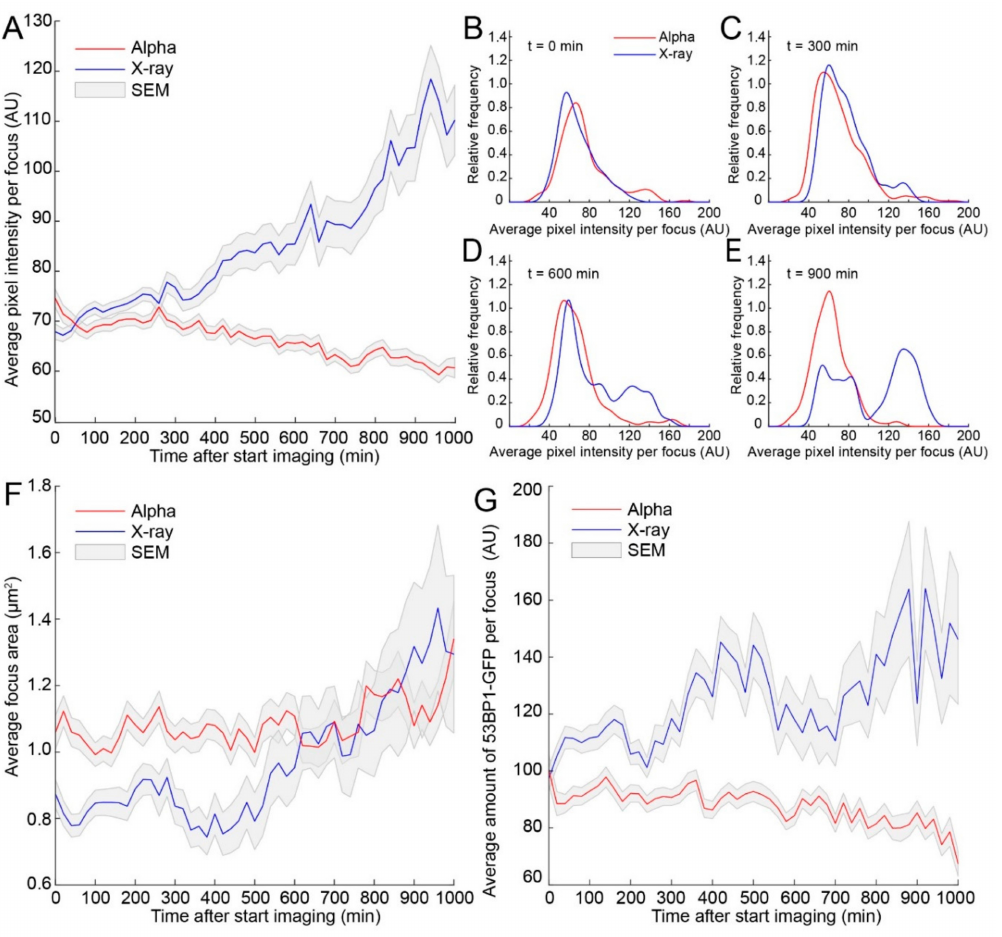
Figure 3. 53BP1-GFP protein accumulation and focus size increase after X-ray irradiation. ( A ) Average 53BP1-GFP intensity per focus (average pixel intensity) over time after treatment using α -particle (red) or X-ray (blue) irradiation (2 Gy). ( B – E ) Overview of focus population distribution at 0, 300, 600, and 900 min after the start of imaging. Graphs shown kernel density estimations with the area under the curve being equal to the area of the histogram. The 0 AUs are the consequence of the smoothing procedure used for density estimations. ( F ) Average 53BP1-GFP focus area trough time. The average of foci induced by α -particles (red) or foci induced by X-ray (blue). ( G ) Total amount of 53BP1-GFP (product of focus area and pixel intensity) on foci through time after α -particle (red) or X-ray (blue) irradiation. SEM is indicated in